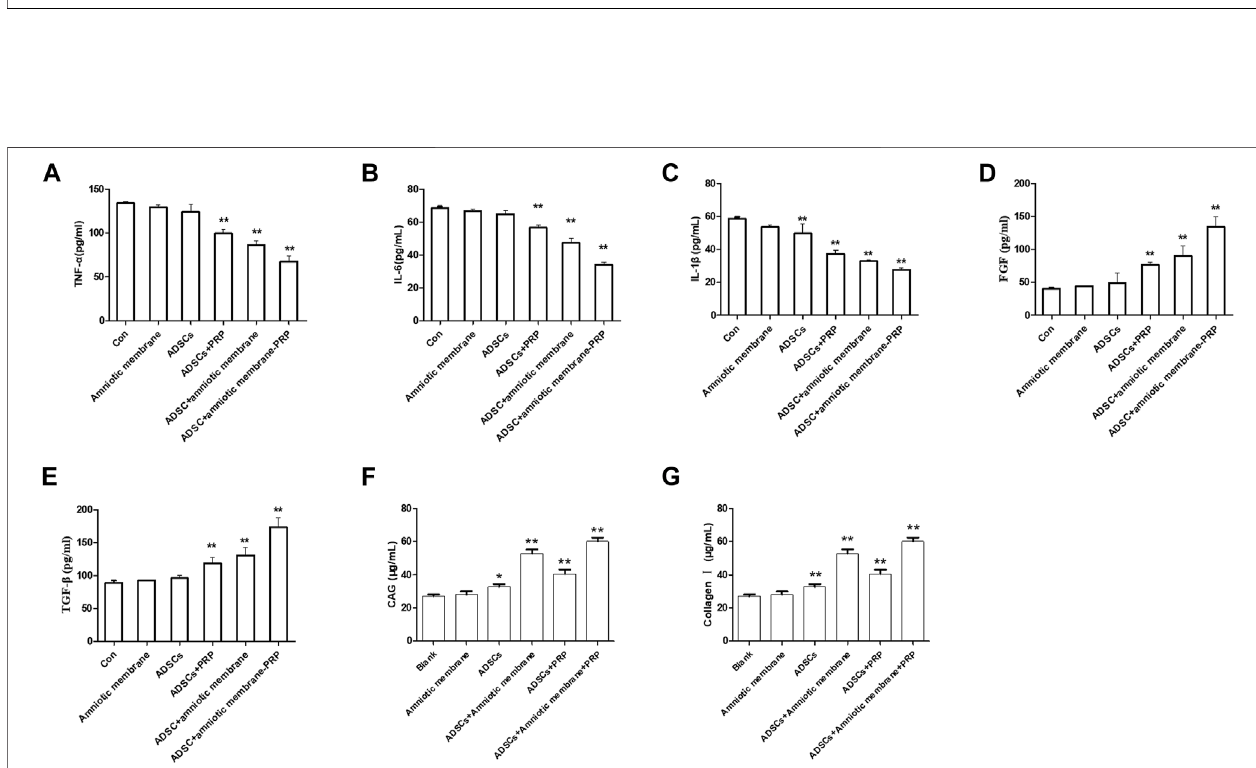
FIGURE 10 | The combination of amniotic membrane and PRP scaffolds upregulated the levels of glycosaminoglycan, collagen, TGF- β , PDGF, and FGF while decreased the level of IL-1 β , IL-6, and TNF- α . (A – C) The detection of the levels of (A) TNF- α , (B) IL-1 β , and (C) IL-6 in different groups by ELISA assay. Six groups were included for the analysis, including the control group, ADS alone, amniotic membrane alone, ADSC + amniotic membrane, ADSC + PRP, and ADSC + amniotic membrane + PRP. Five rabbits were included for every group (* p < 0.05, ** p < 0.01, all groups were compared with the control group; a p -value of less than 0.05 was considered as statistically signi fi cant). (D – G) The detection of (D) FGF, (E) TGF- β , (F) glycosaminoglycan, and (G) collagen Ⅰ in different groups by ELISA assay. Six groups were included for the analysis, including the control group, ADSC alone, amniotic membrane alone, ADSC + amniotic membrane, ADSC + PRP, and ADSC + amnioticmembrane+PRP.Fiverabbitswereincludedforeverygroup(* p < 0.05,** p < 0.01,allgroupswerecomparedwiththecontrolgroup;a p -valueoflessthan0.05 was considered as statistically signi fi cant).